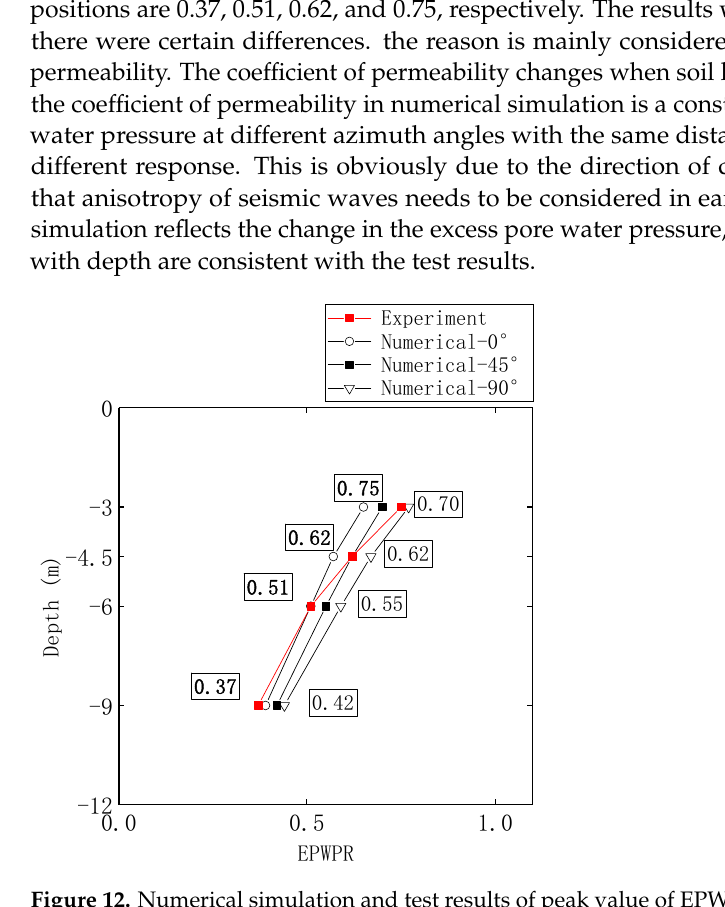
Figure 11. Numerical simulation and test results of peak acceleration at different depth in soil.